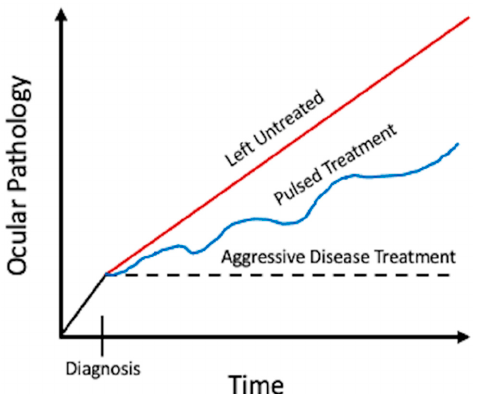
Figure 2. Our hypothesized rate of pathological changes in a uveitic eye with or without treatment. Red line, no treatment; blue line, periodic steroid pulses (either locally or systemically), black dotted line, adequately treated uveitis .